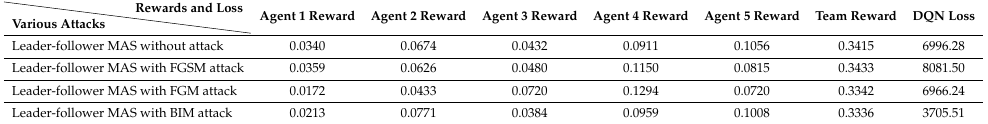
Table 4. Comparison of each agent’s average reward and DQN loss of a heterogeneous MAS, including N = 5 agents in P = 3 different clusters, during 30,000 time steps by considering time- delay and distance-based reward after adversarial attack defense Algorithm 1.